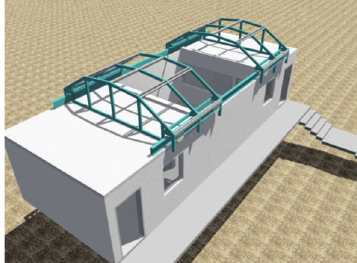
Figure 3: Notre Dome de La Silla as designed by ESO. A control room and a warehouse complete the REM building. An IP subnet is reserved for the REM operations and internet access is controlled by ESO internal firewalls. Its sliding roof is also used as a crane to mount and dismount